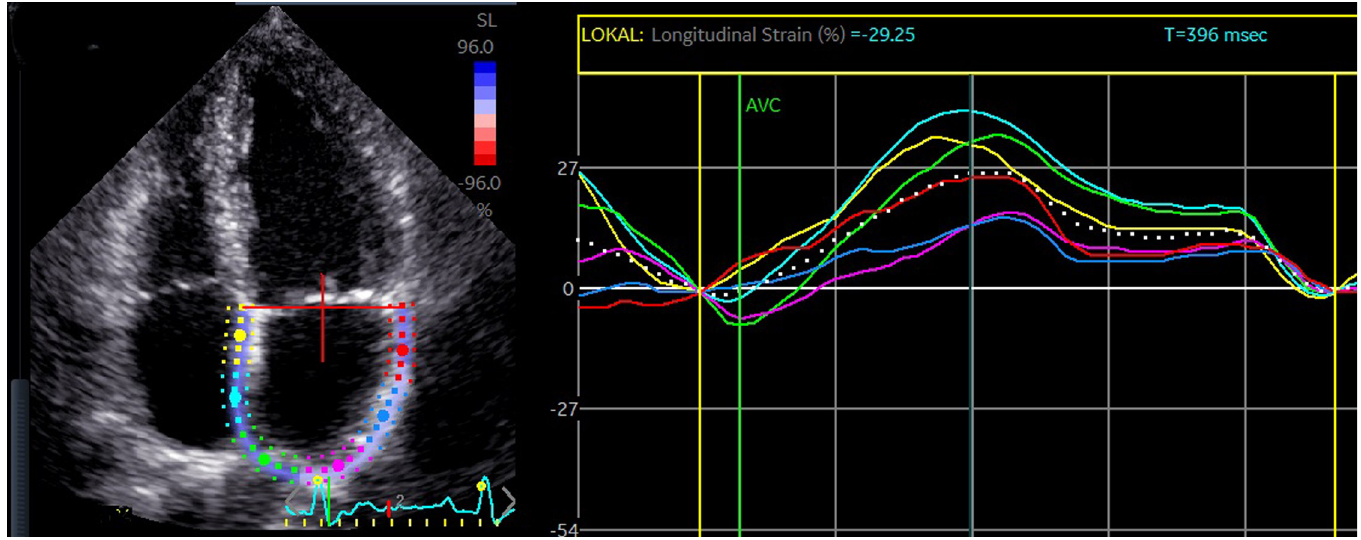
Fig 2. Two-dimensional left atrial (LA) reservoir strain from apical 4-chamber view. The current proband shows a LA strain function of 26%.